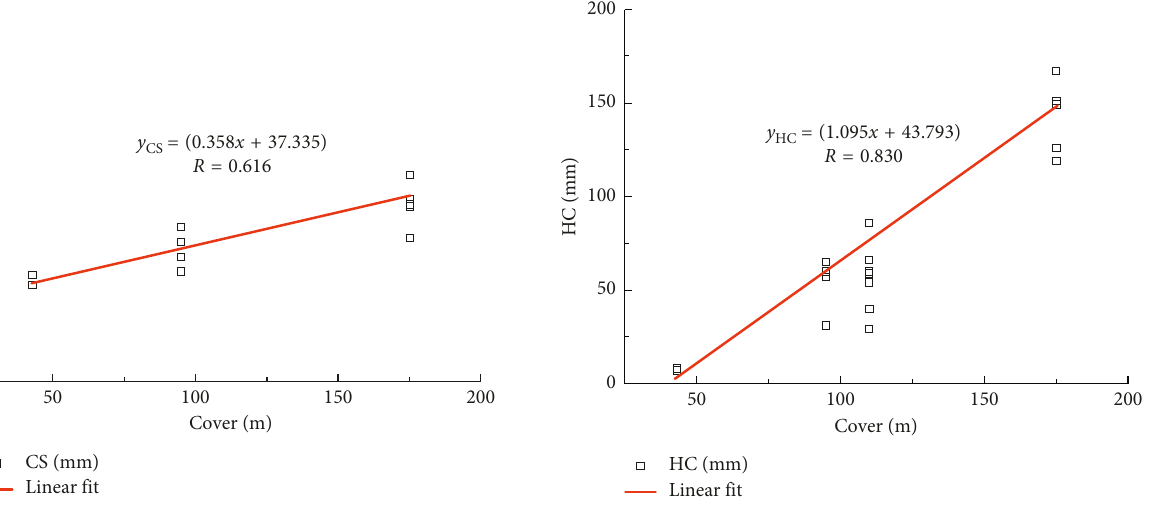
Figure 7: Linear regression between CS and cover depth at 15.2m span.